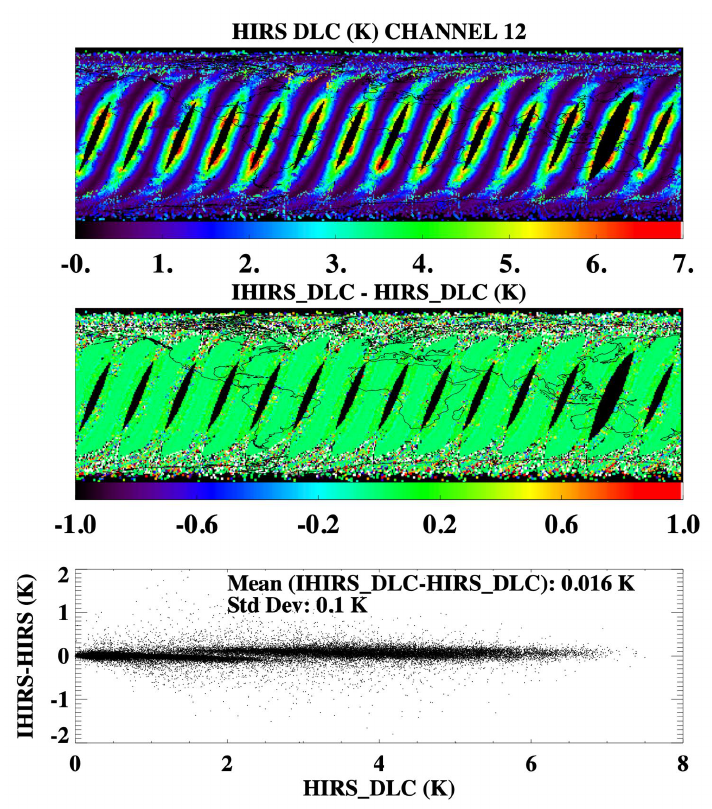
Figure 5. Same as Figure 4, but for channel 12. Remote Sens. 2023 , 15 , x FOR PEER REVIEW